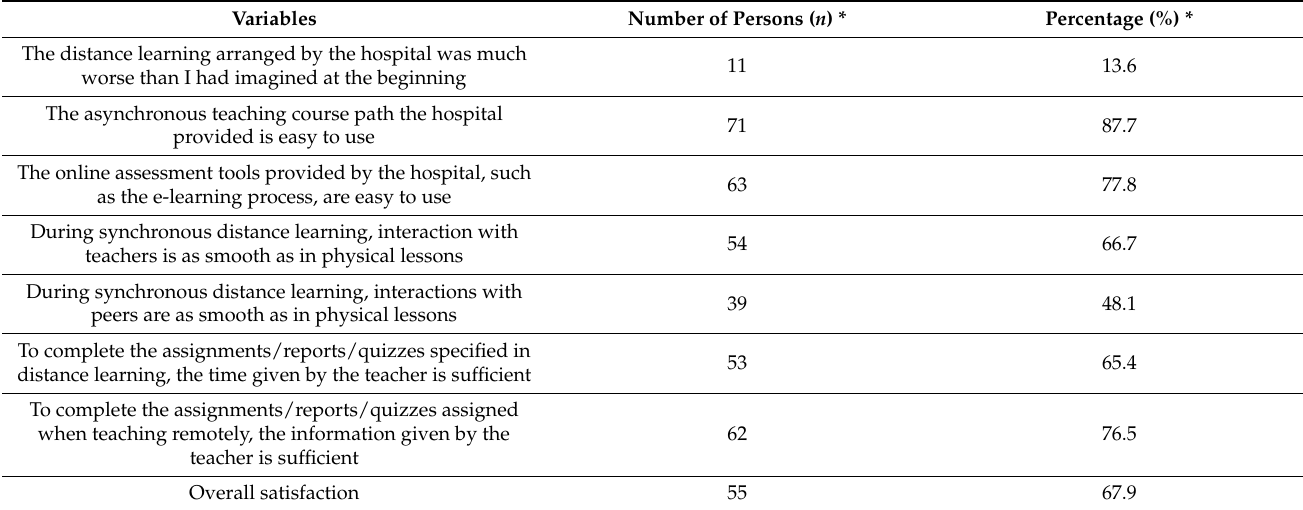
Table 2. Students’ perceptions regarding the distance-learning portion of the